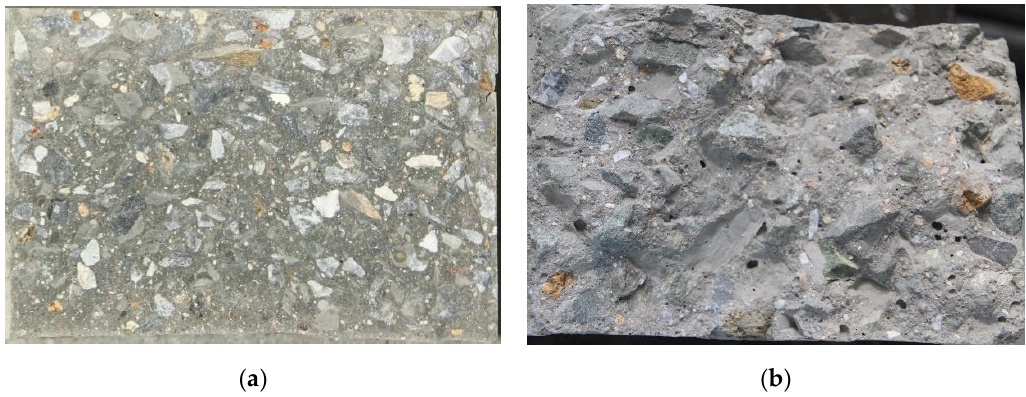
Figure 7. The fracture surface of concrete at different temperatures: ( a ) at 5 °C; ( b ) at 60